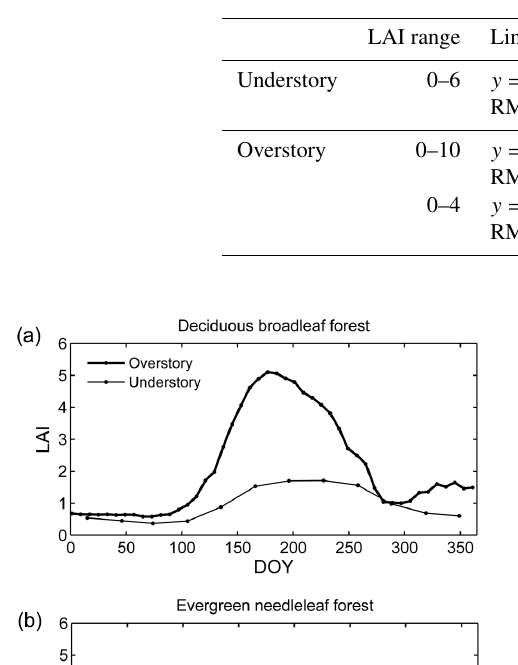
Table 3. Pixel-by-pixel comparison of the GLOBMAP LAI o and LAI u with the Kobayashi datasets (Kobayashi et al., 2010) over the larch forest in eastern Siberia.